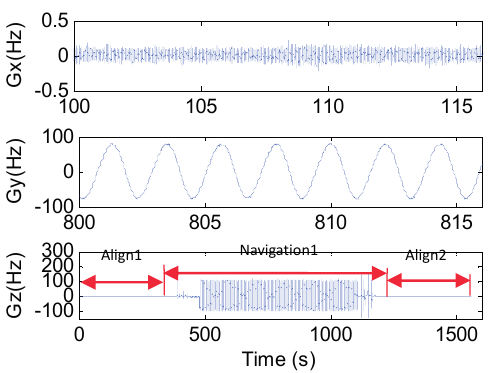
Figure 5 . Processing by new filter.